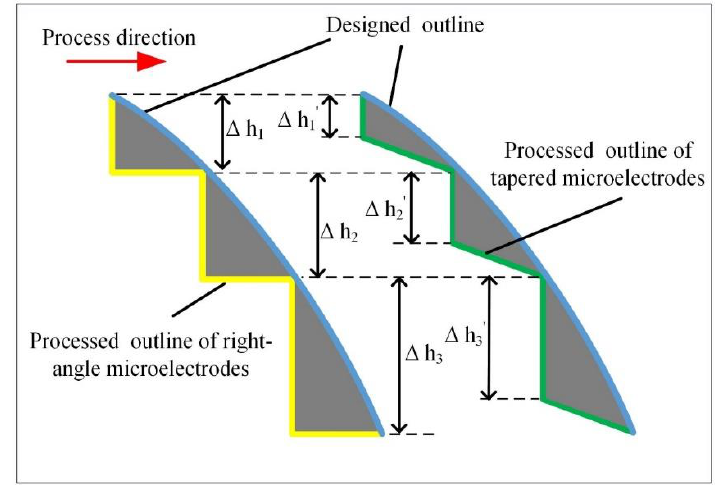
Figure 5. The height difference of the processing results of the adjacent